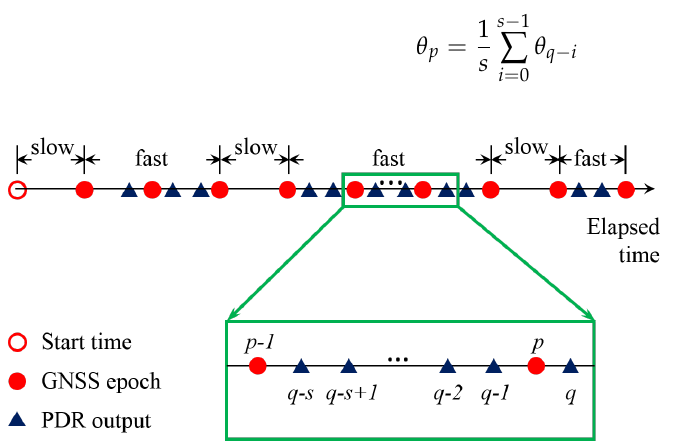
Figure 3. Schematic diagram of PDR and GNSS output